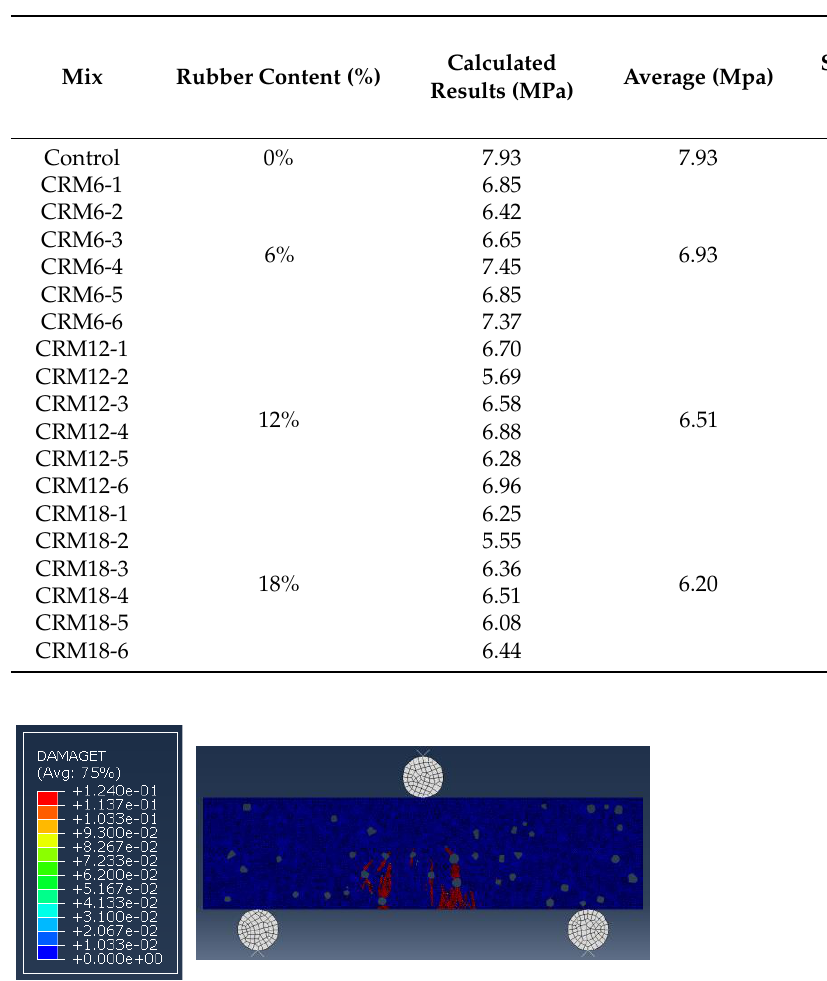
Figure 24. Pore-based mesoscale model of the 2D CRM12 sample. Table 11. The flexural strength of CRM obtained by numerical simulation.